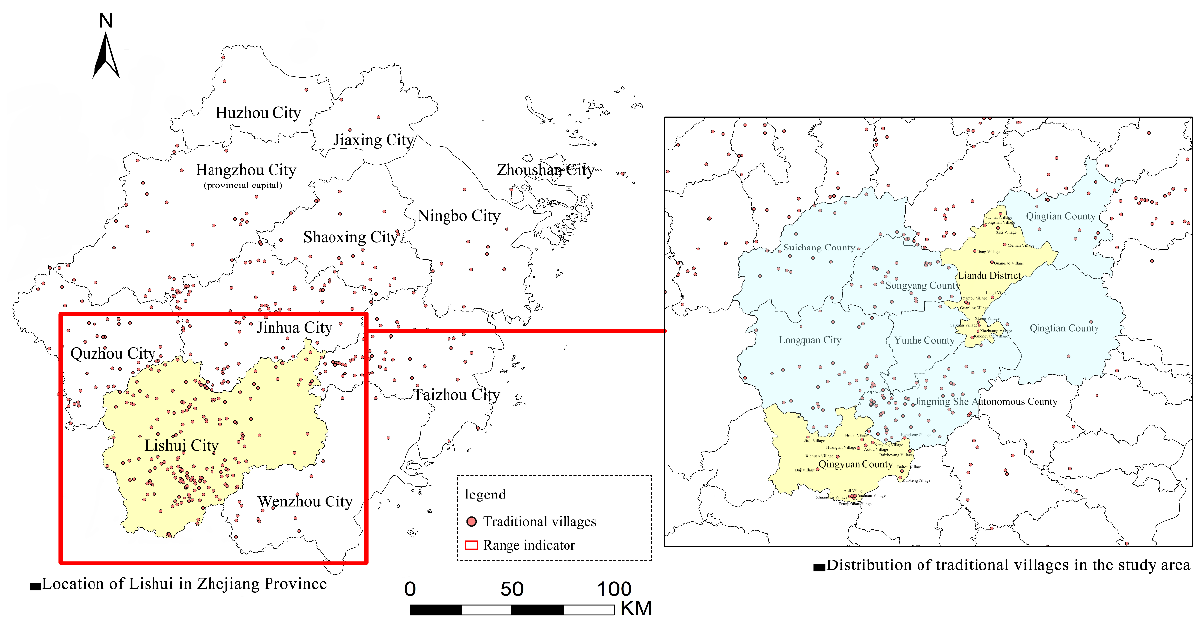
Figure 3. Location of study area.